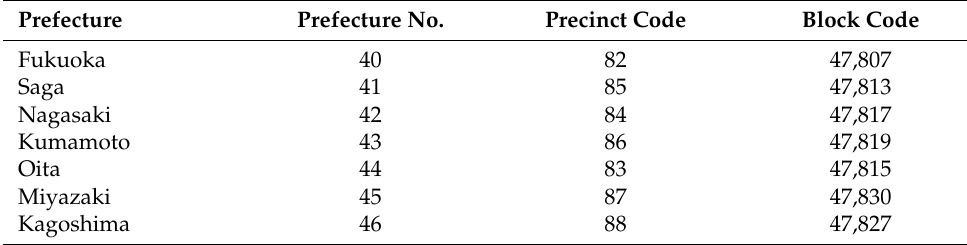
Table 1. Weather stations in